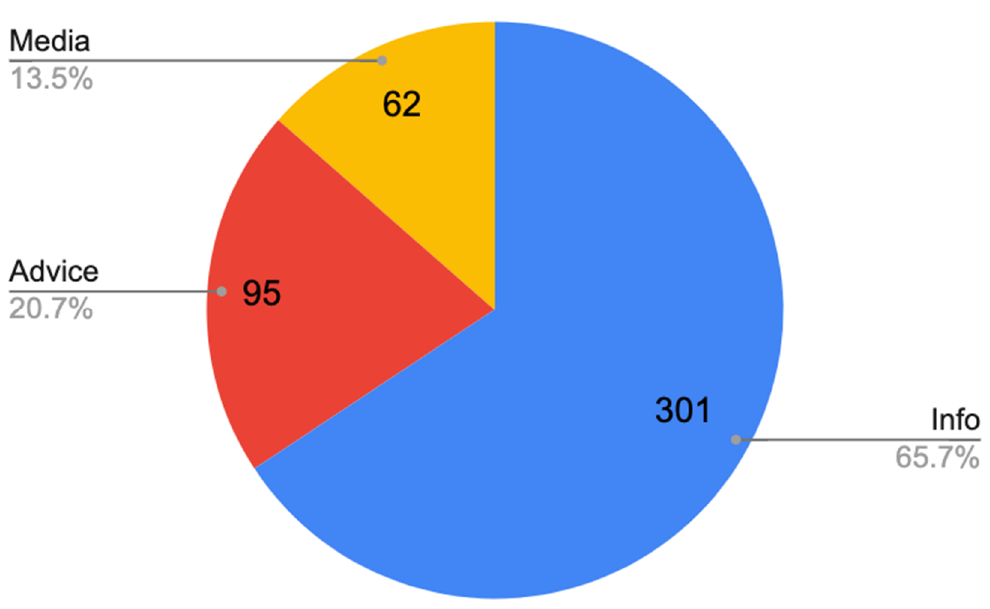
Figure 6. Type of message. Source: own elaboration.